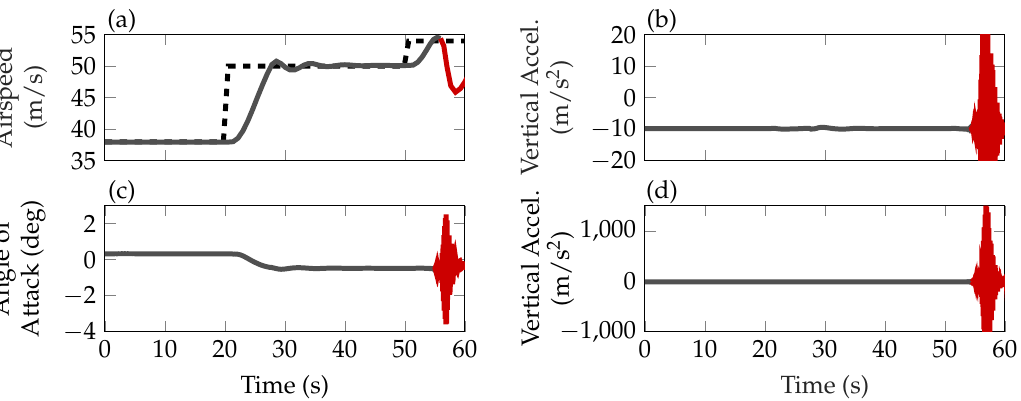
Figure 9. Simulation results without flutter suppression controller for an acceleration scenario for indicated airspeed ( a ), accelerations on the wing root ( b ), angle of attack ( c ), and accelerations on the wing tip ( d ). The flight in the stable regime is indicated in gray ( ), the unstable situation in red (